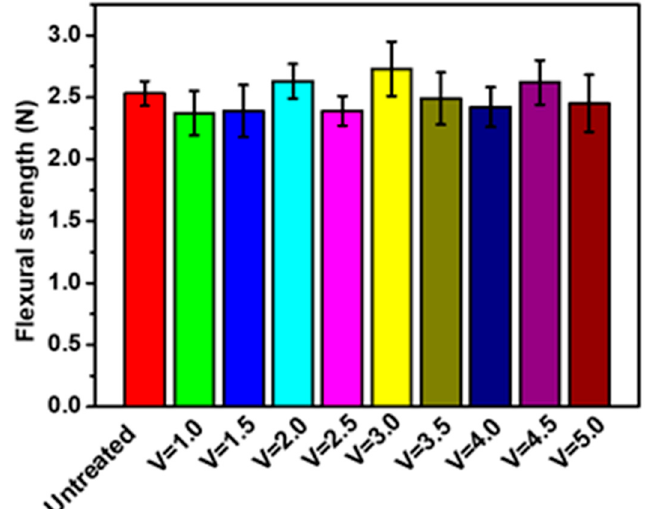
Figure 12. Flexural strength of braid-reinforced composite hollow fiber tubes with different coating speeds and uncoated stainless steel wires.